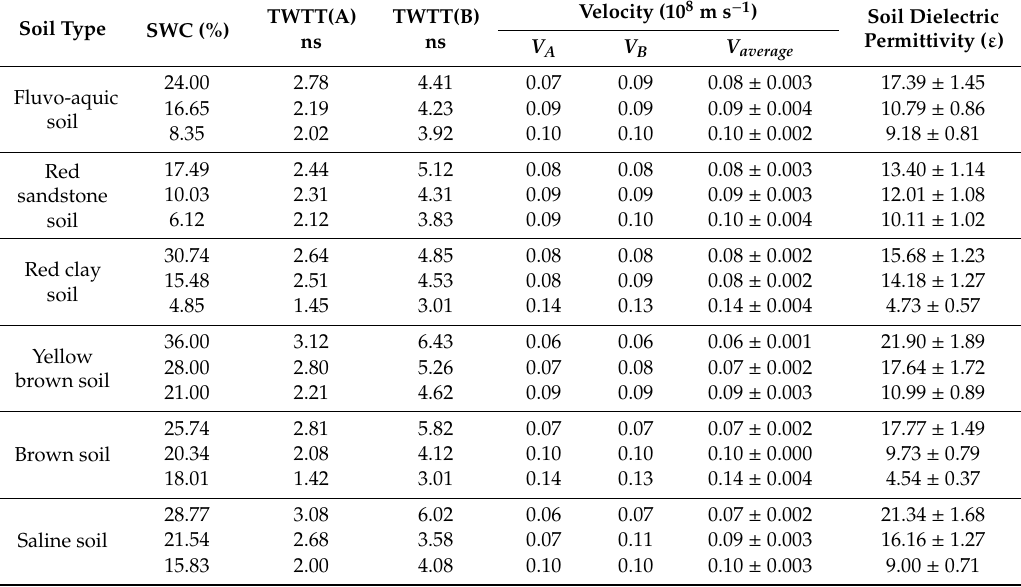
Table 3. GPR electromagnetic wave two-way travel times (TWTTs) and average velocities with various soil water